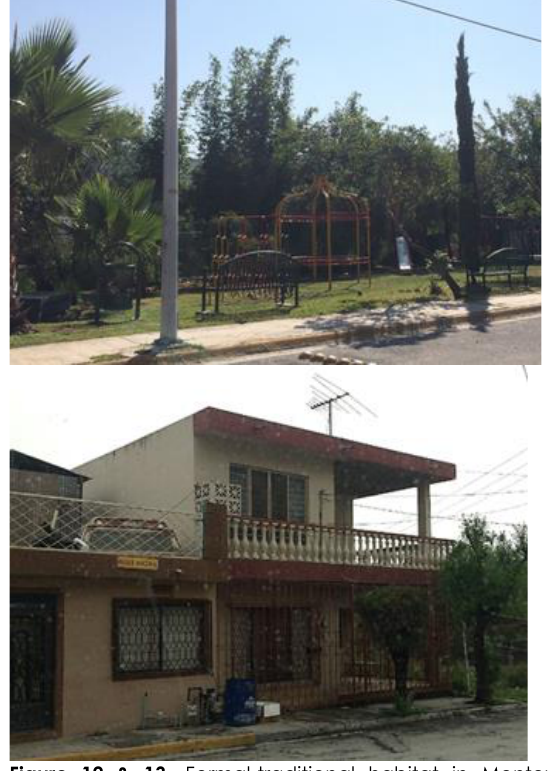
Figure 12 & 13. Formal-traditional habitat in Monterrey, Mexico (Gómez, 2015).